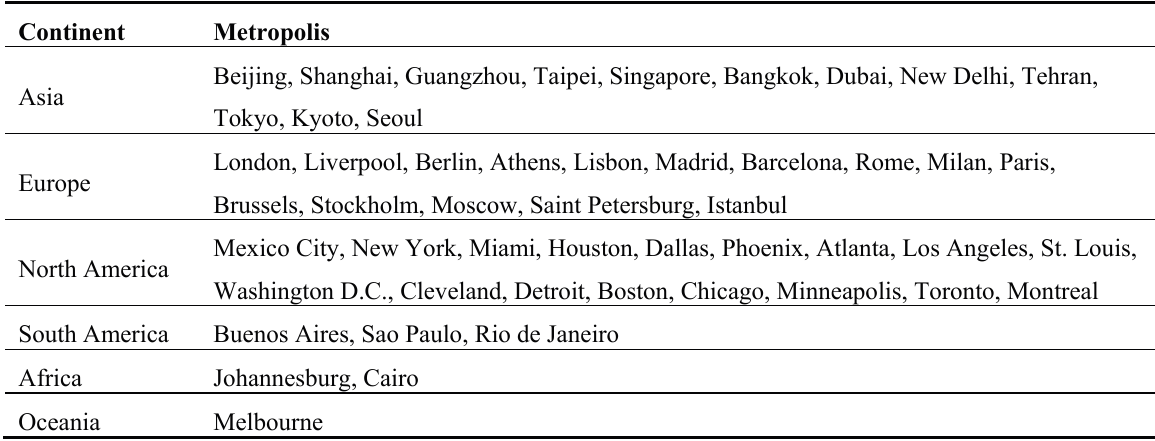
Table 2. The distribution of the selected